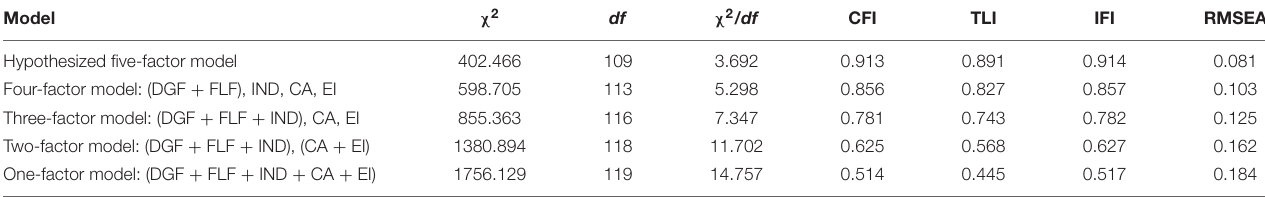
TABLE 2 | Confirmatory factor analysis results for the measurement models.